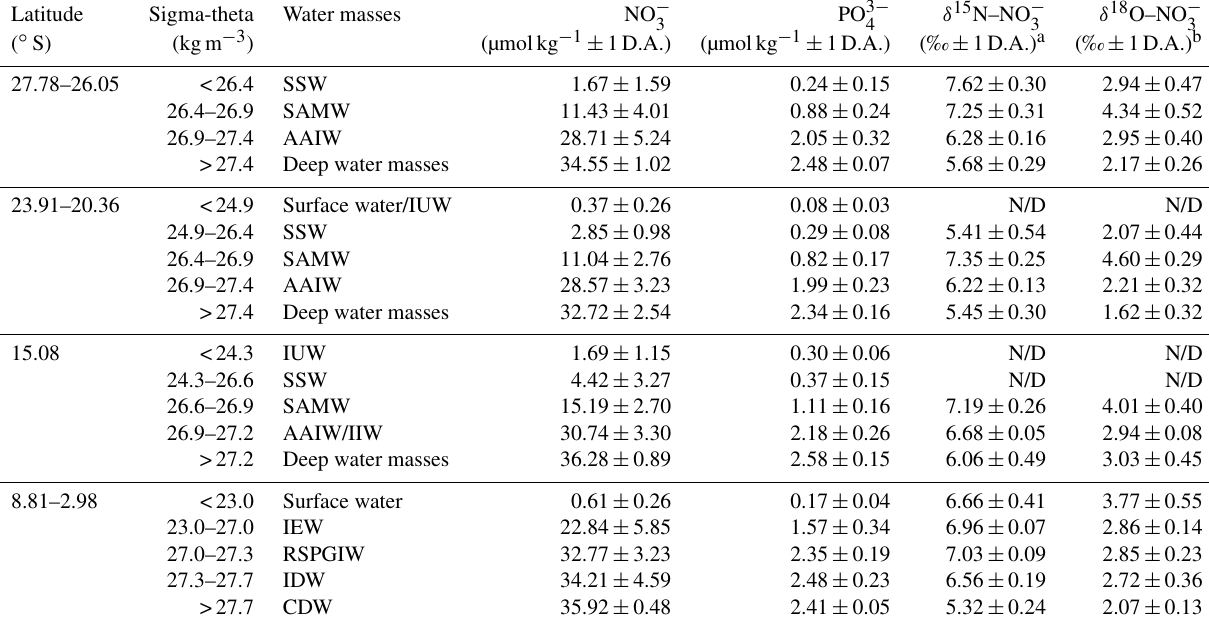
Table 1. Average nitrate and phosphate concentrations and average δ 15 N–NO − Indian Ocean, defined along their potential density surfaces (sigma-theta) and separated into four latitudinal sections (27.78–26.05 ◦ S; 23.91– 20.36 ◦ S; 15.08 ◦ S; and 8.81–2.98 ◦ S). Water mass abbreviations are as follows: Indonesian Upper Water (IUW), Subtropical Surface Water (SSW), Subantarctic Mode Water (SAMW), Indian Equatorial Water (IEW), Antarctic Intermediate Water (AAIW), Indonesian